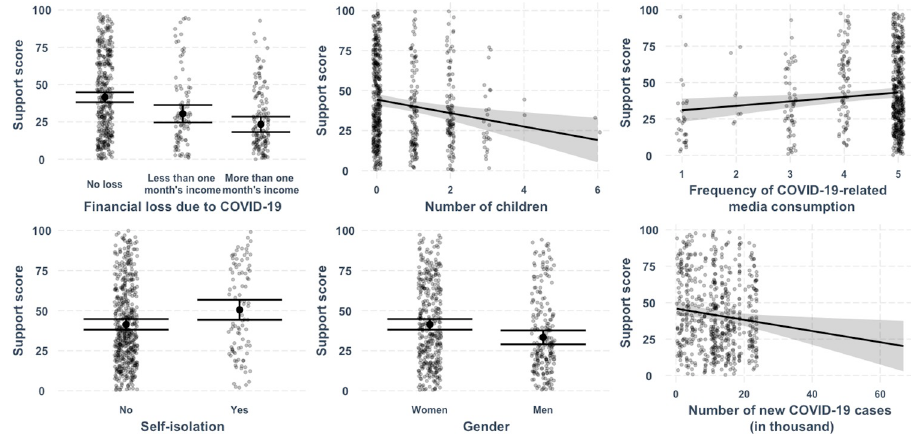
Fig 3. Predicted values of the support score for different values of financial loss, number of children, media consumption, self-isolation, new COVID-19 cases, and gender. 95% confidence intervals are shown for predicted values where all other predictors are held constant, i.e., their mean values are used. Grey dots display the predicted data with the effects of all other predictors accounted for.